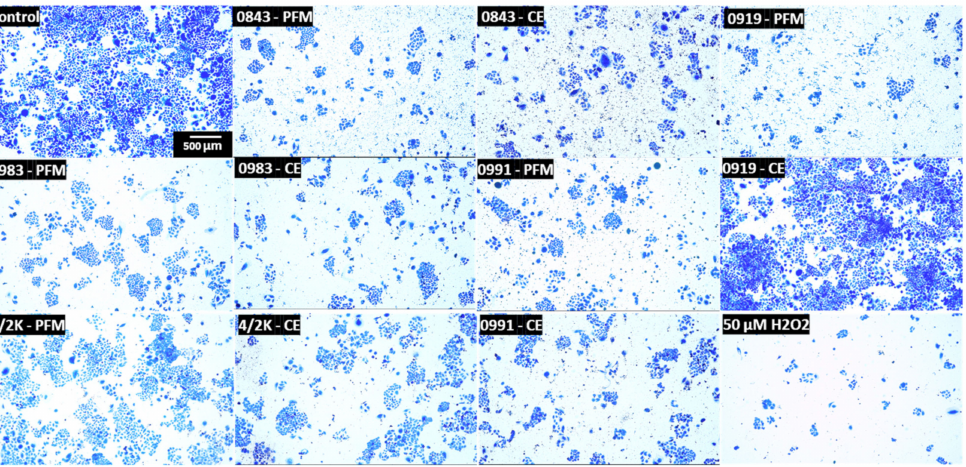
Figure 1. Photographs presenting colonies produced by Caco-2 cells following plating of 1000 cells and 7 days incubation. Cells were treated with 20% ( v/v ) concentration of post-fermentation media (PFM) or cell extracts (CEs) for 60 min. 50 µ M H 2 O 2 was used as a positive control. Negative control, untreated cells. Cells were observed under 5 × objective in an inverted microscope Nikon Ts2, with EMBOSS contrast (Nikon, Tokyo,